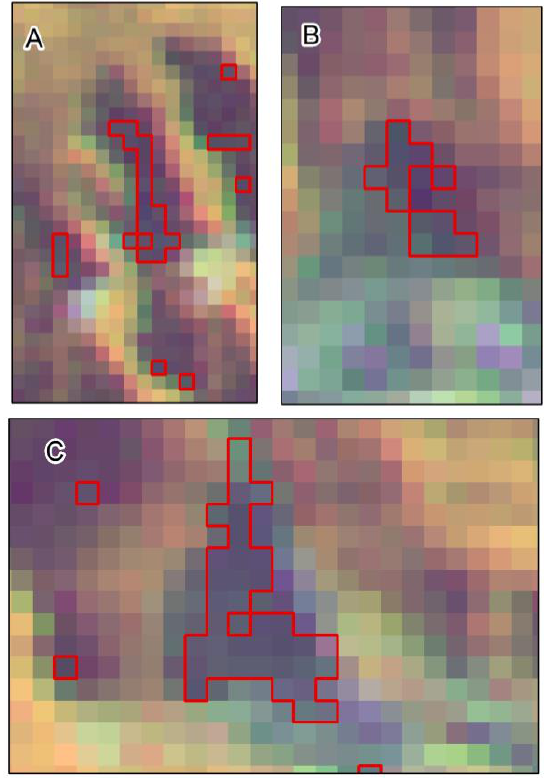
Figure 11. Additional landslide features identified in the study area. ( A ) landslide events occurred close to a road segment; ( B ) a landslide detected nearby an urban area; ( C ) a steep slope of exposed soil near an oil refinery.